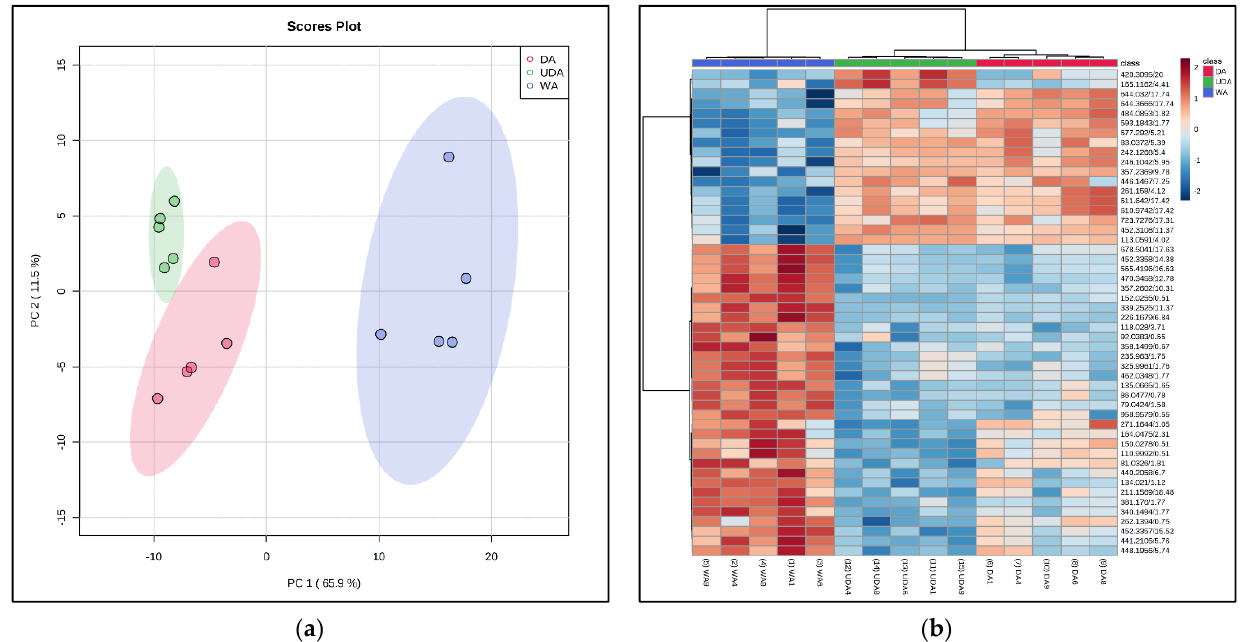
Figure 3. Principle component analysis (PCA, ( a )) and hierarchical clustering analysis (HCA, ( b )) of significant metabolites from pork loins ( M . Longissimus lumborum ) aged for 21 days with different aging treatments: wet-aging (WA), conventional dry-aging (DA), and UV-light dry-aging (UDA). Table 6. Effect of different aging treatments on metabolomics profile of pork loins ( M . Longissimus lumborum ) aged for 21 days ( p -value < 0.05 and FDR < 0.05).